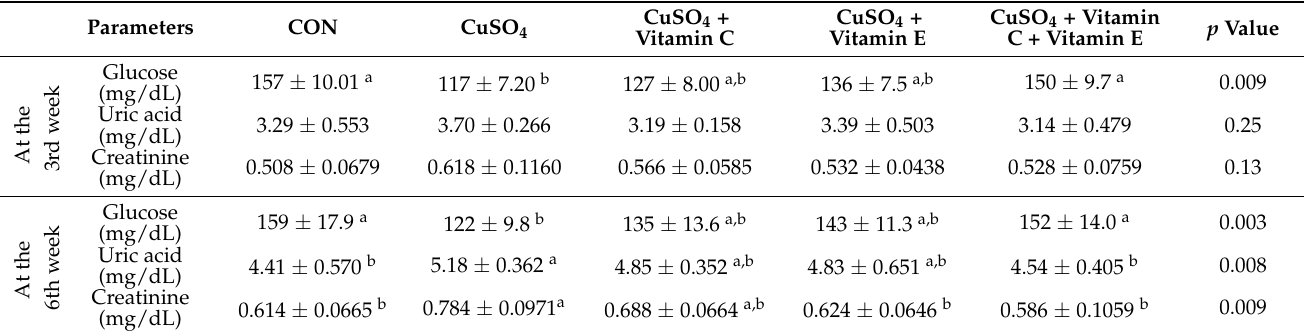
Table 4. Effect of single or combined supplementation of vitamin C and E on the serum glucose and renal biomarkers of CuSO4-intoxicated broiler chickens (Mean ± SD, n =